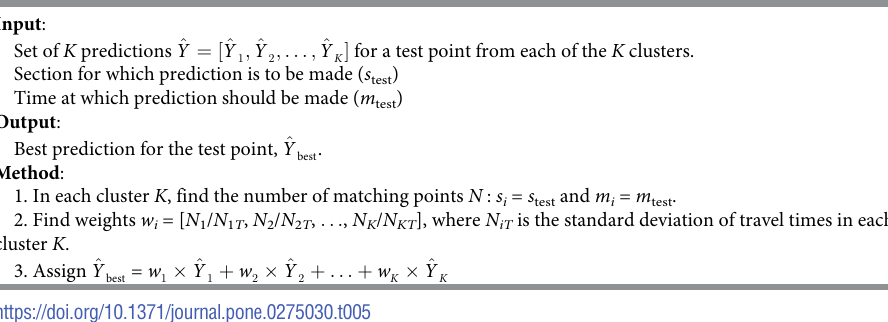
Table 5. Fusion-based